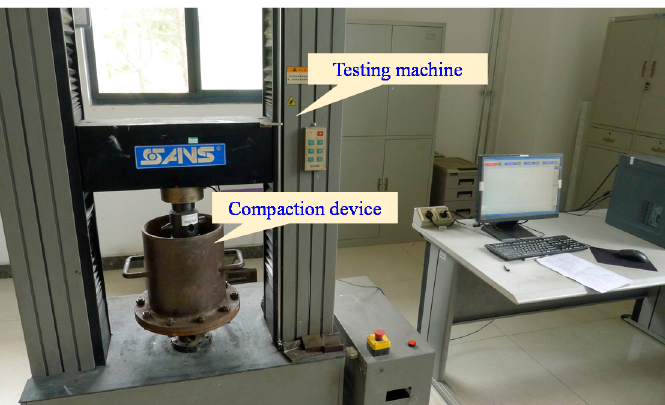
Figure 5. The testing machine and a self-built compaction device.